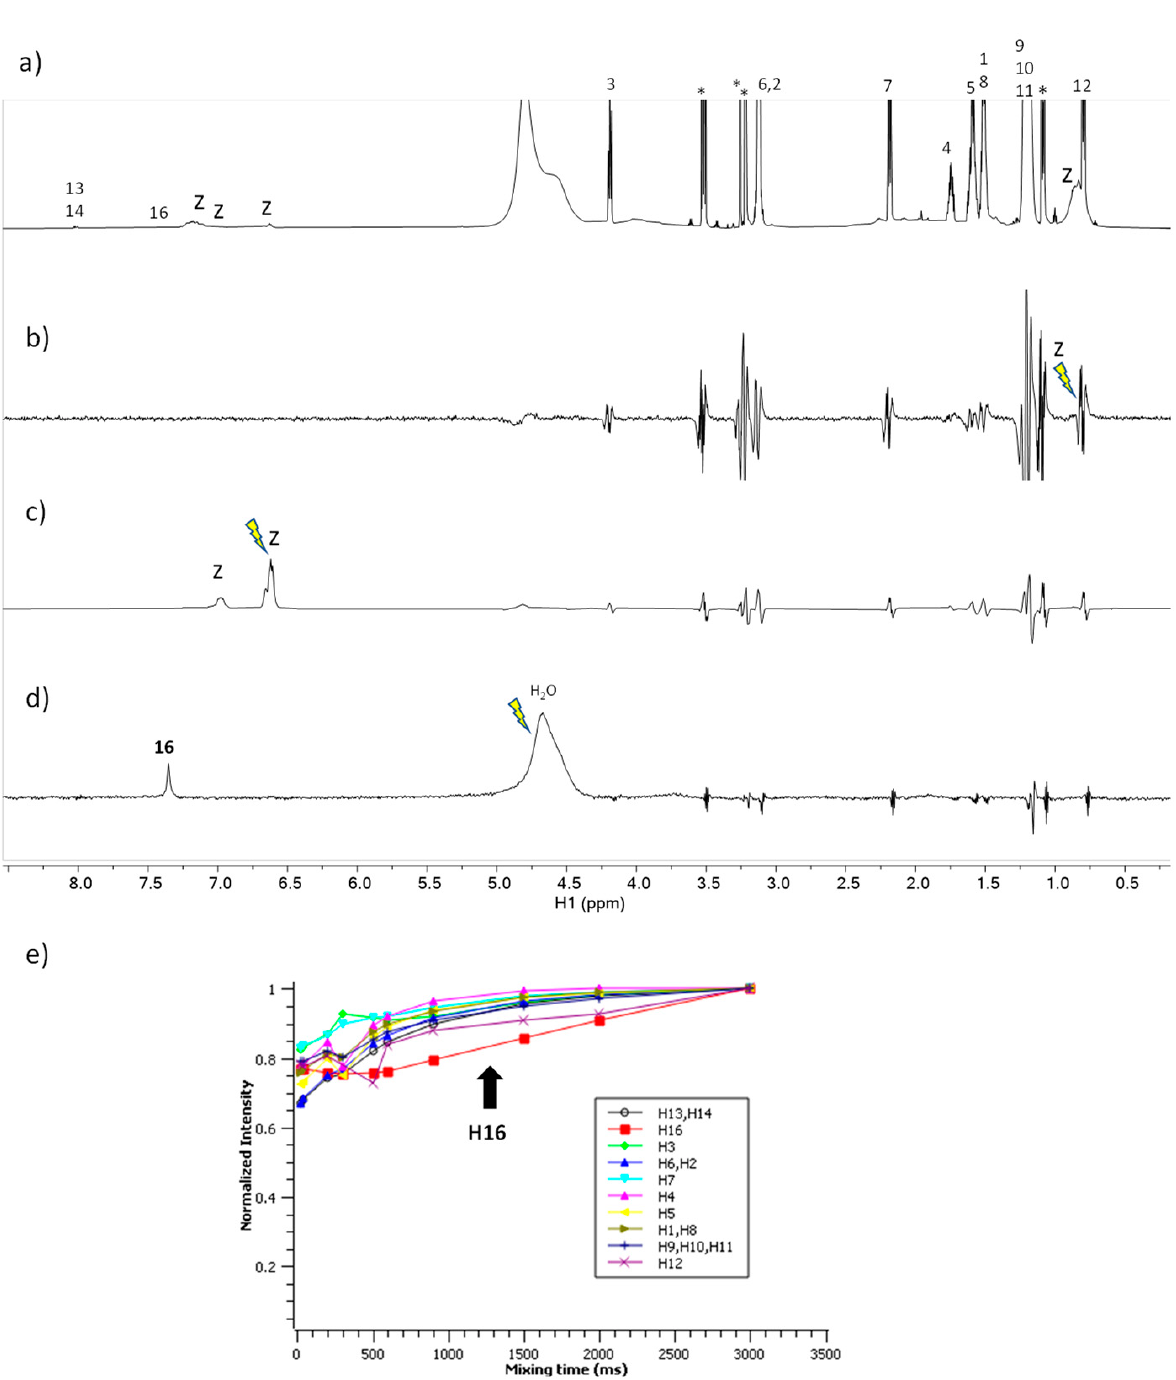
Figure 6. NMR binding interaction study between surfactant C 3 (LA) 2 and zein. ( a ) 1 H NMR ( b , c ) STD off-on with on-saturation applied over the signal of zein at ( b ) 0.82 ppm and ( c ) at 6.5 ppm ( d ) waterLOGSY spectrum with mixing time 500 ms. In ( b – d ) the signal selectively saturated or inverted is indicated with a ray symbol and the assignment of the relevant surfactant responses is indicated. Some impurities are denoted with asterisks. The letter z refers to zein signals. ( e ) Plot of the normalized signal intensity of the surfactant protons as a function of mixing time of the NOE-exch